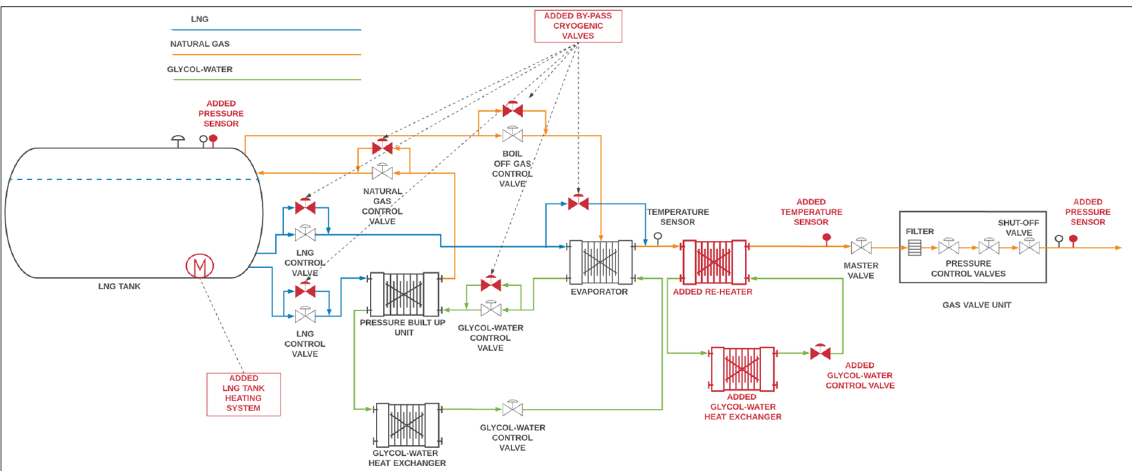
Figure 8. Modified LNG fuel feeding system to accommodate the proposed changes towards safety enhancement.